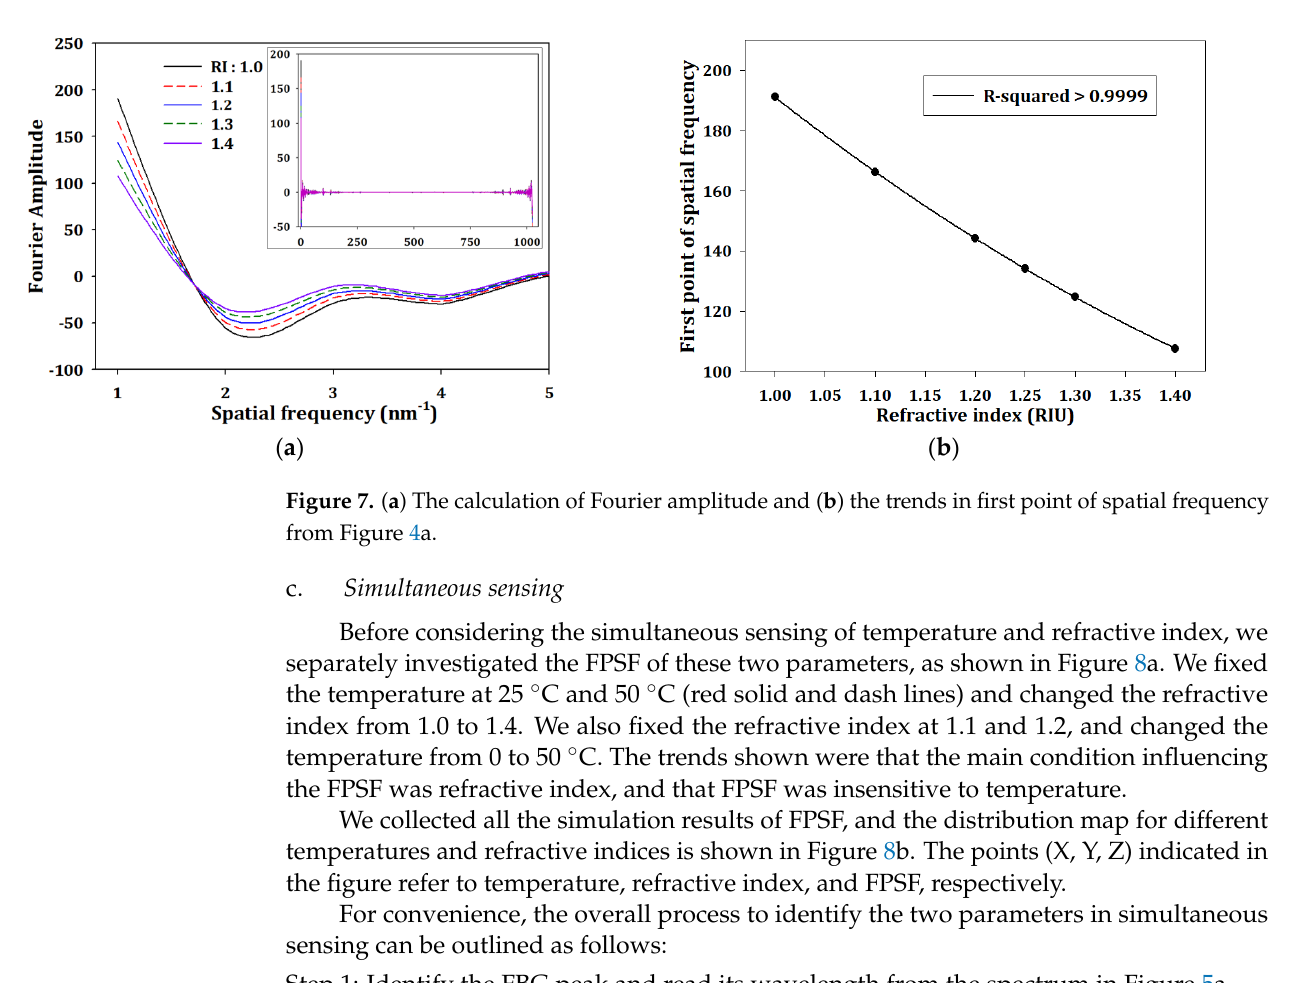
Figure 8. ( a ) The FPSF distribution with different temperatures and a refractive index of 1.3, ( b ) the